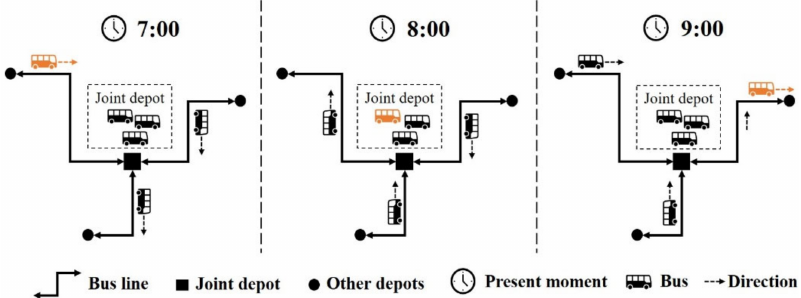
Figure 1. Schematic diagram of vehicle centralized management in the multi-line operation